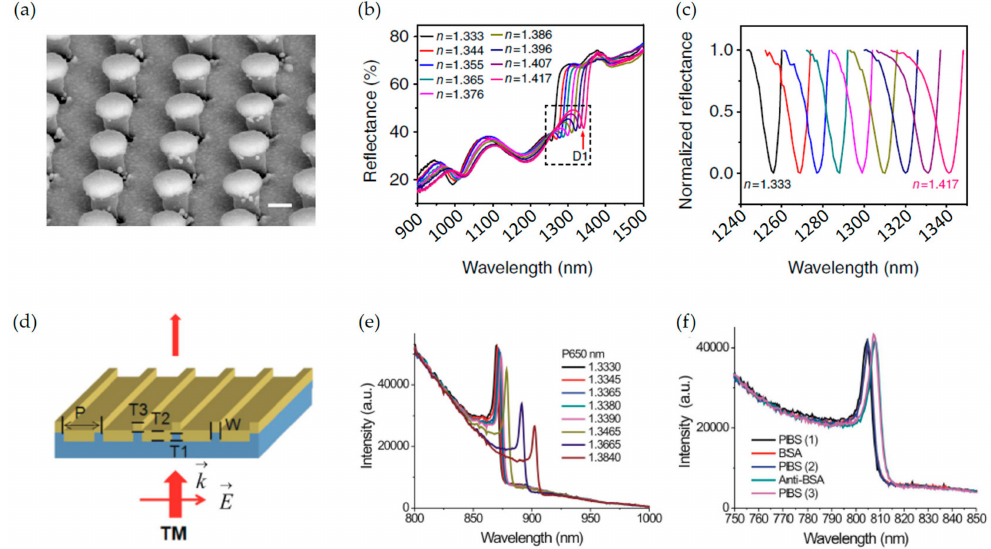
Figure 7. ( a ) Side-view SEM image of gold mushroom MMs. The scale bar is 200 nm; ( b ) Reflectance spectra of the gold mushroom array structure immersed in glycerine at the incidence angle of 33.3 ◦ ; ( c ) Normalized relfectance spectra for D1 in the spectral region indicated with the dashed box in ( b ). The refractive index changes from 1.333 to 1.417 (black to pink); ( d ) A schematic configuration, depicting the geometrical parameters of the capped gold nanoslits, as well as the direction of the TM-polarized incidence with E and K vectors; ( e ) Intensity spectra of the capped gold nanoslit with a 650-nm period in carious water/glycerin mixtures for a normally-incident TM-polarized wave; ( f ) Measured intensity spectra for different surface conditions. Reprinted by permission from Macmillan Publishers